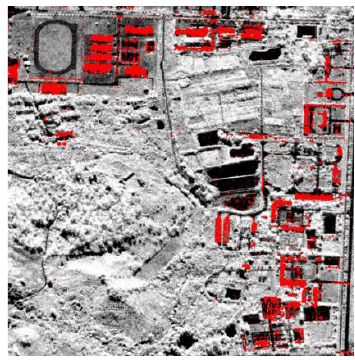
Figure.7. Man-made objects detection result of test area 2.